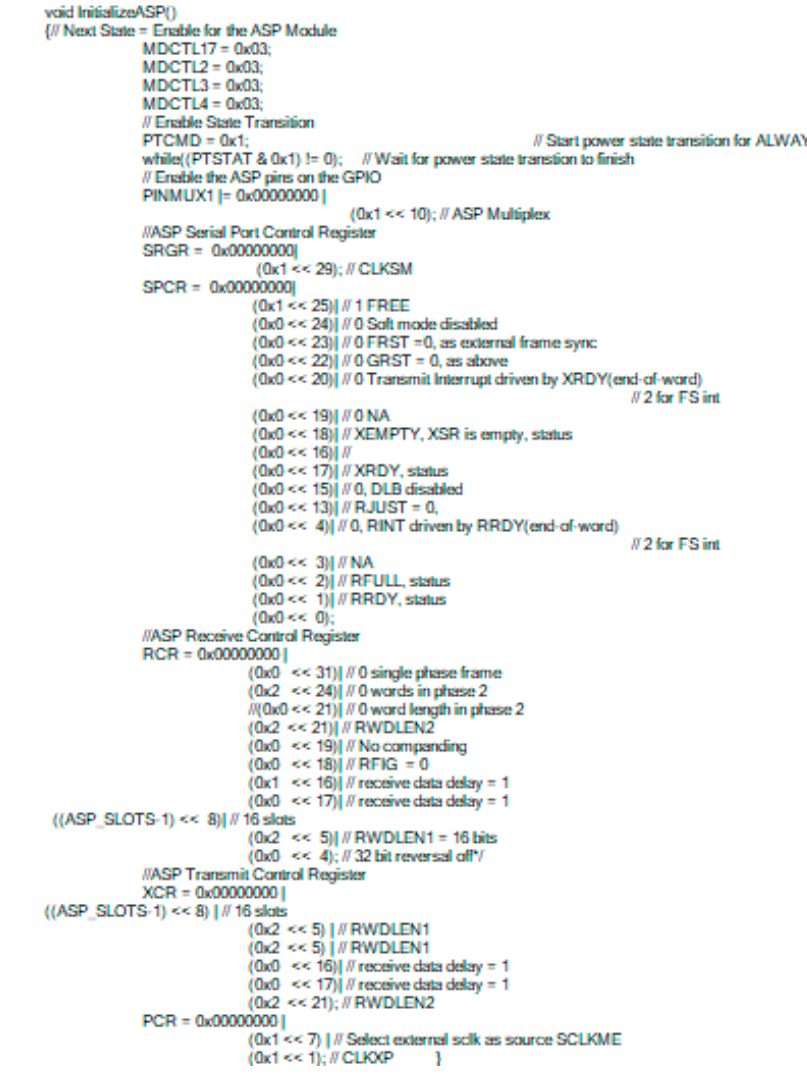
Figure 8. Initialize ASP function Code.